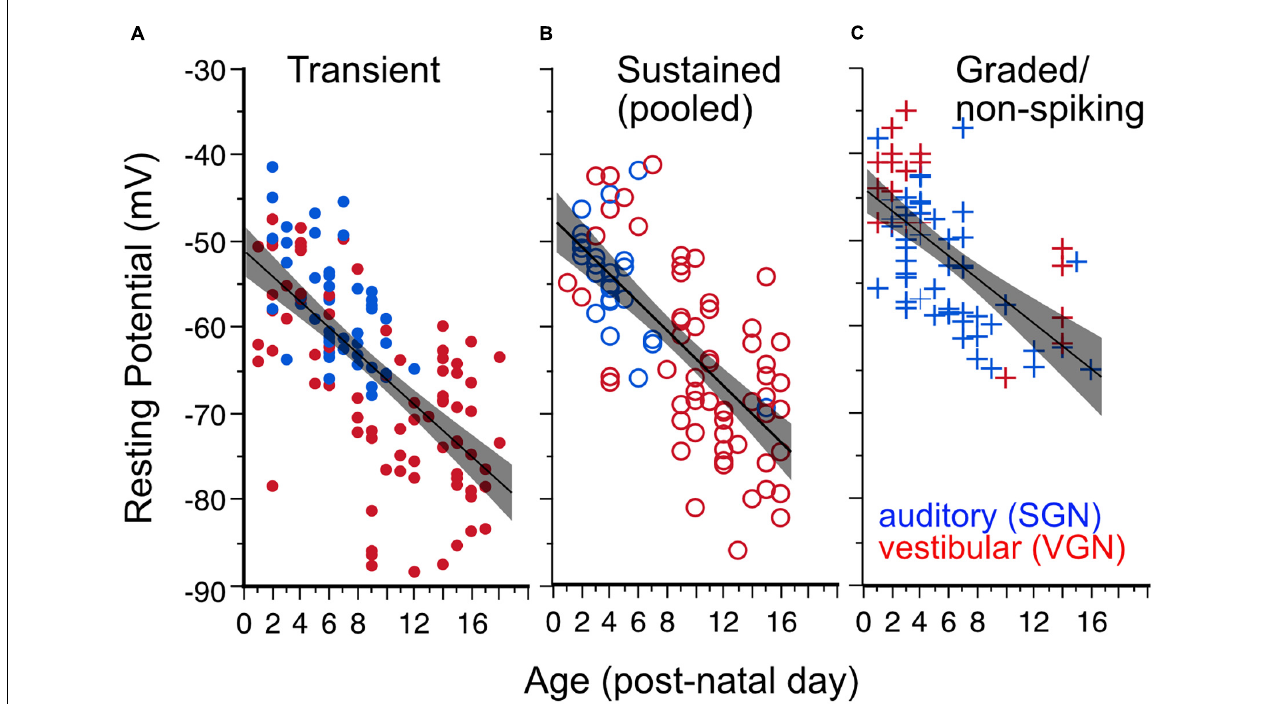
FIGURE 3 | Resting potential hyperpolarizes with age for all firing pattern groups. Lines plus shaded areas show linear regressions plus 95% confidence intervals. Blue symbols indicate spiral ganglion neurons, whereas red symbols indicate vestibular ganglion neurons. Each data point represents the resting potential of individual ganglion neurons. (A) Resting potential vs. postnatal age in transient-spiking somata. Y (Resting Potential) = –1 – 1.49*X (post-natal age). F (1, 129) = 100.92, p = 0.0001. (B) Resting potential vs. postnatal age in sustained-spiking neurons. Here sustained-A and sustained-B groups are pooled together and represented by open circles. Y = –47.56 – 1.615*X. F (1, 82) = 80.10, p ≤ 0.0001. (C) Resting potential vs. postnatal age in non-spiking/graded neurons. Y = –44–1.306*X, F (1,69) = 45, p < =